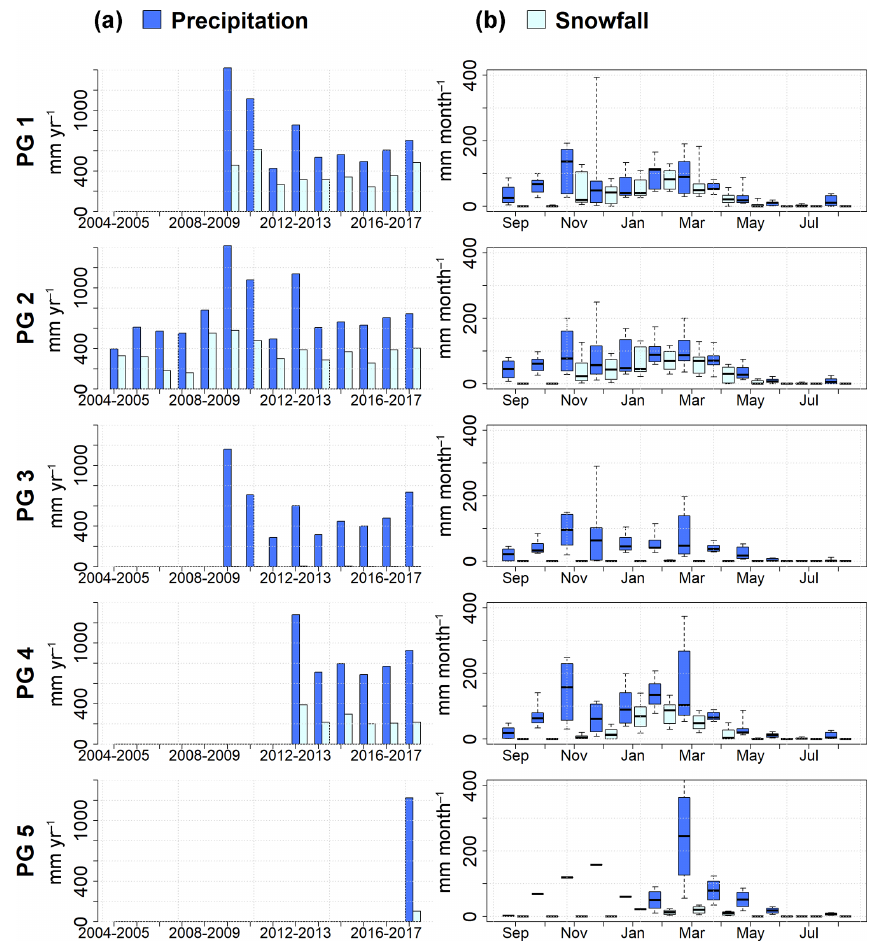
Figure 7. Precipitation and snowfall in the weather stations of the Guadalfeo Network in Sierra Nevada (Spain). Column (a) shows annual precipitation and snowfall at each station during the 2004–2016 period. Column (b) shows mean monthly precipitation and snowfall at each station during the study period; box plots show the mean values (black line), interval range and the 10th and 90th percentiles (whiskers) of each sample (series duration in Fig.